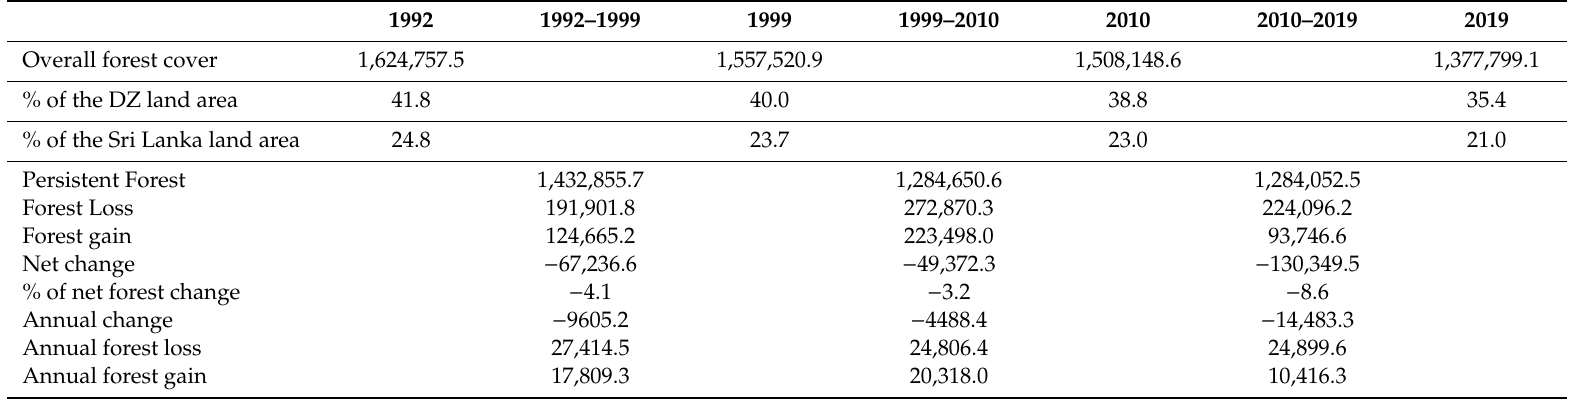
Table 1. Forest cover change (ha) in the DZ of Sri Lanka from 1992 to 2019 for changes in persistent forest cover, losses and gains, net forest-cover change, and annual trends in forest-cover